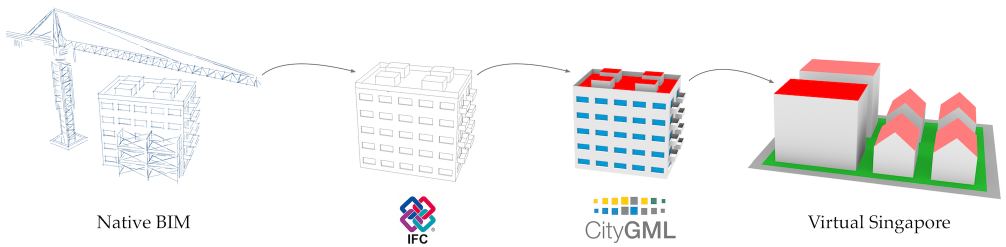
Figure 1. The project in a nutshell: from native BIM (Building Information Model) to the integration of CityGML models in Virtual